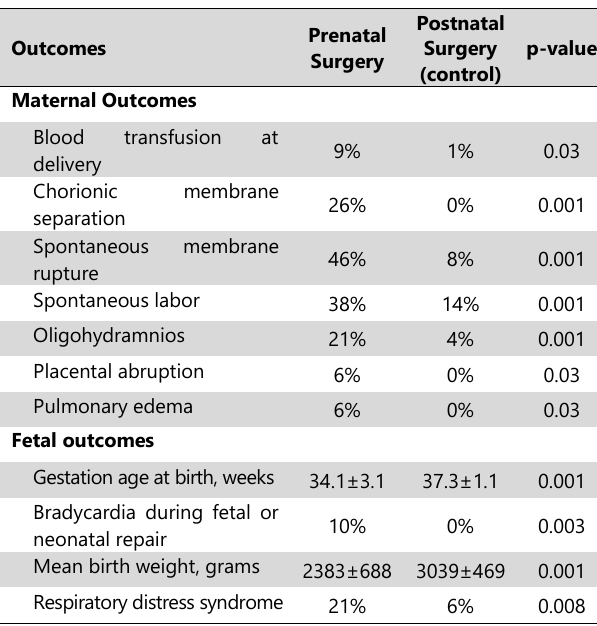
Table 2 . Comparing Both Statistically Significant Maternal and Fetal Outcomes Arising from Prenatal vs Postnatal